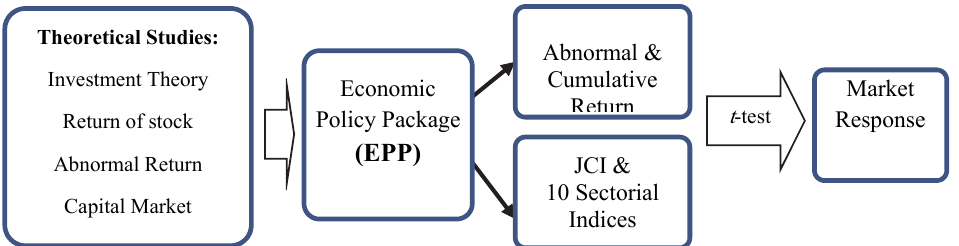
Fig. 1. Research theoretical